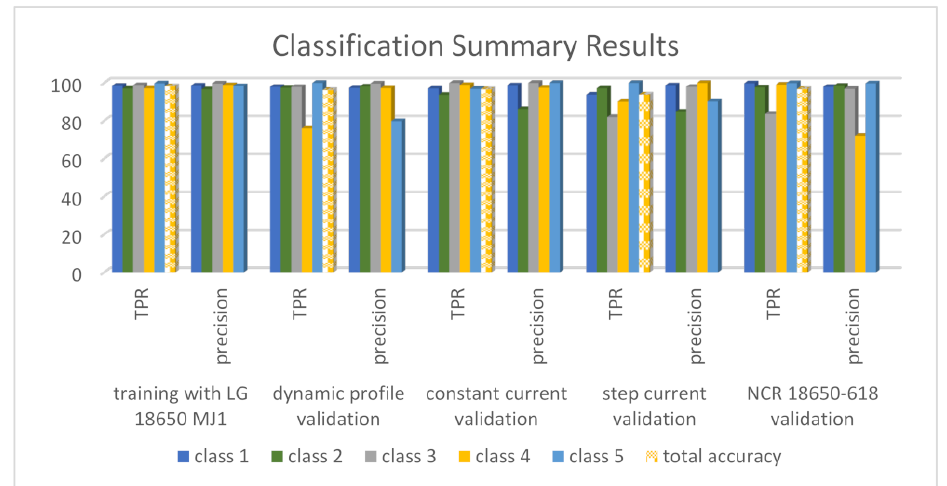
Figure 20. Result summary of the training and validation of the classifier indicating the TPR, precision per class, and the total accuracy of the classifier according to the confusion